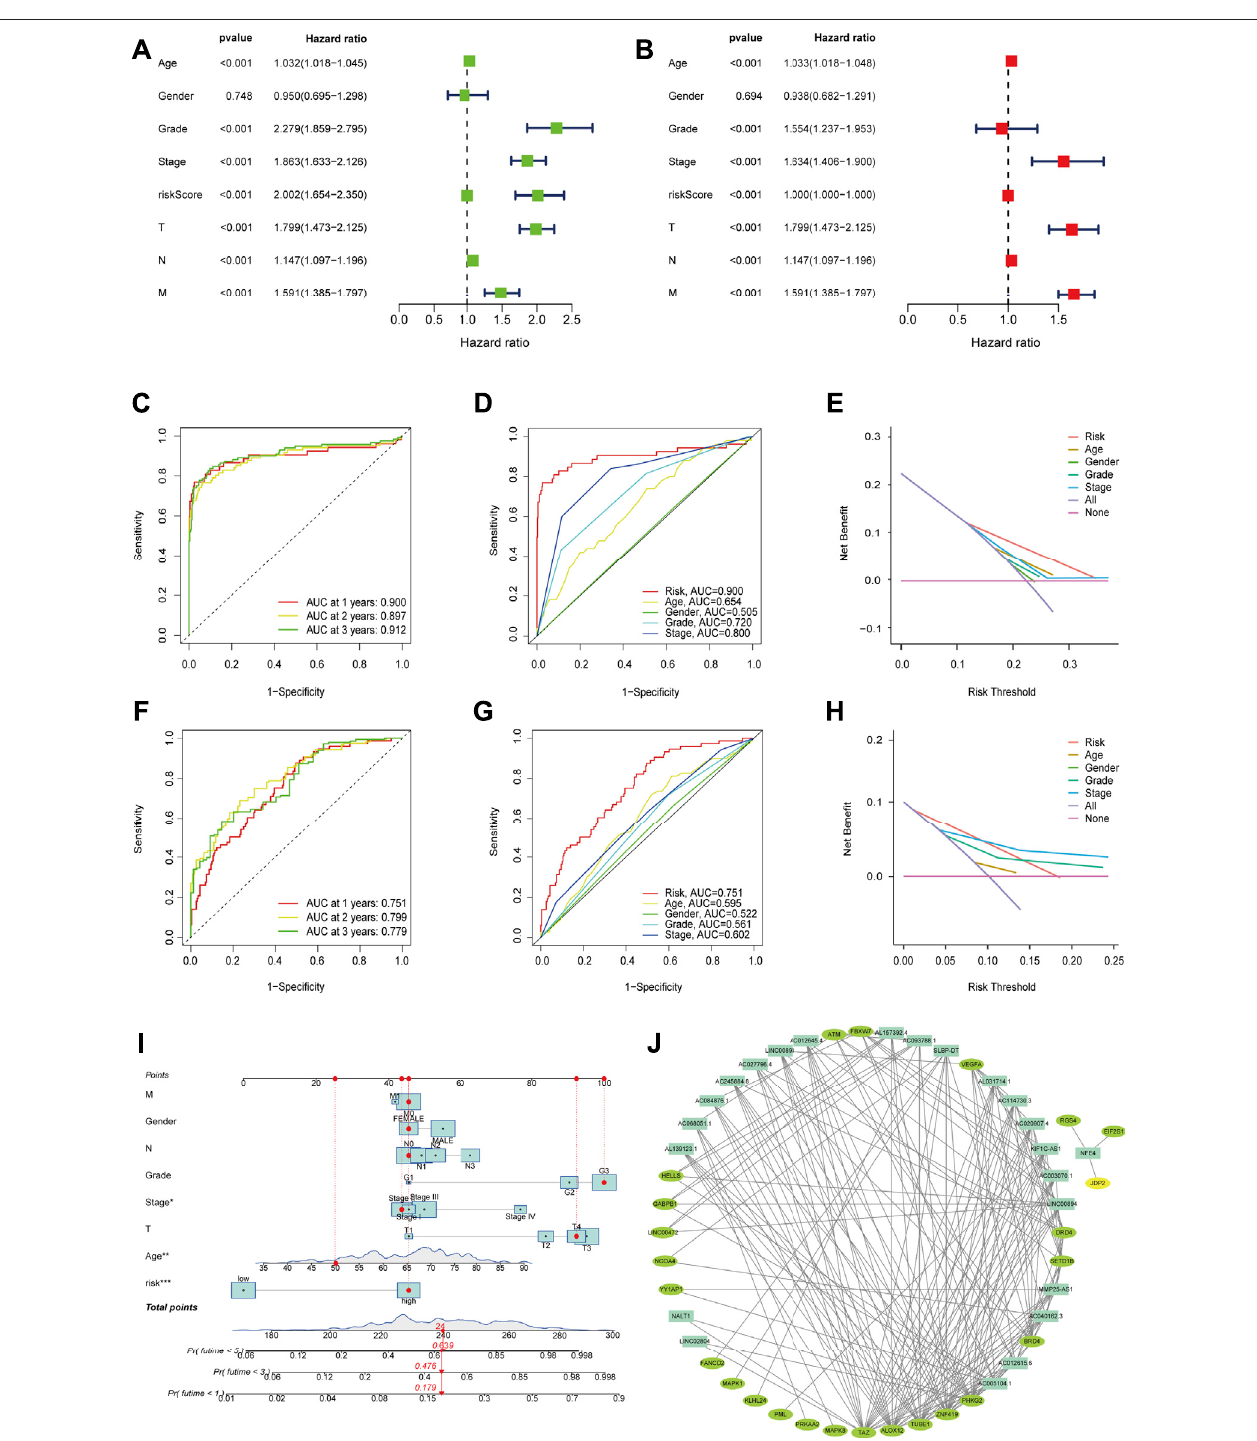
FIGURE3| EvaluationofIndependentPrognosticFactorsandConstructionofNomograph (A) UnivariateCoxregressionanalysisshowedthecorrelationbetween overall survival rate and various clinicopathological parameters (Age, Gender, Grade, Stage, T and M stage). (B) Multivariate Cox regression analysis showed that age, grade, stage, and riskscorewere independent prognostic indicators forthe overallsurvivalofccRCC patients. (C) The year 1,2, and 3ROCcurves testi fi edthat therisk score is well predictive in the training dataset. (D) ROC curve analysis showed the prognostic accuracy of risk score and clinicopathological parameters in the training dataset. (E) The DCA showed that it was better predictive than other indicators in the training dataset. (F) The year 1, 2, and 3 ROC curves testi fi ed that the risk score is well predictive in the testing dataset. (G) ROC curve analysis showed the prognostic accuracy of risk score and clinicopathological parameters in the testing dataset. (H) TheDCAshowedthatitwasbetterpredictivethan otherindicatorsinthetesting dataset. (I) Theprognosticnomogram constructed based ontheriskscore of FRLs and clinicopathological parameters predicted the survival rate of ccRCC patients at 1, 3, and 5 years. (J) A co-expression network of FRGs and FRLs.